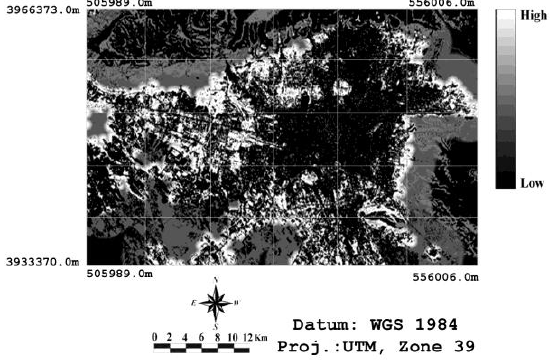
Figure 6. The calibrated normalized urban growth suitability map